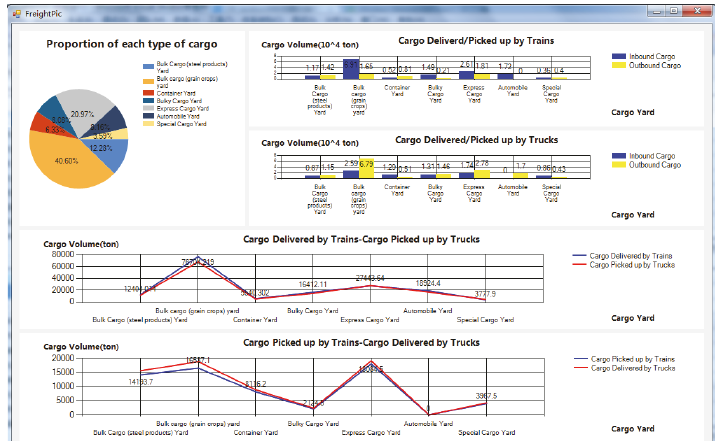
Figure 11: Statistical analysis of cargo volumes based on the simulation